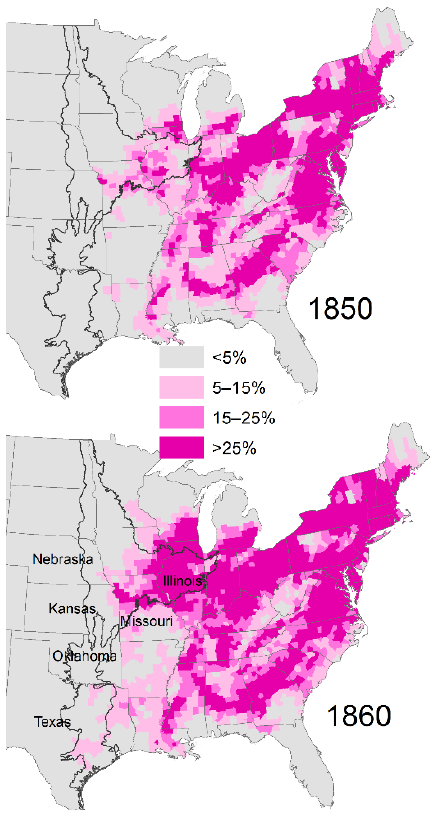
Figure 3. Area in agriculture in 1850 and 1860 (modified from [21]).